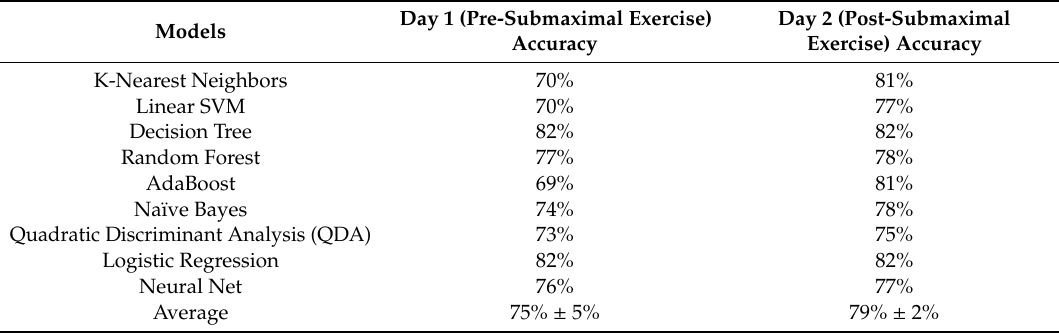
Table 3. Accuracy from the highest performing overall model. Although individually selected regions may have performed higher on di ff erent regions, this model produced the best overall accuracy across all models and one of the highest accuracies (82% for Logistic Regression and Decision Tree) on the validation set